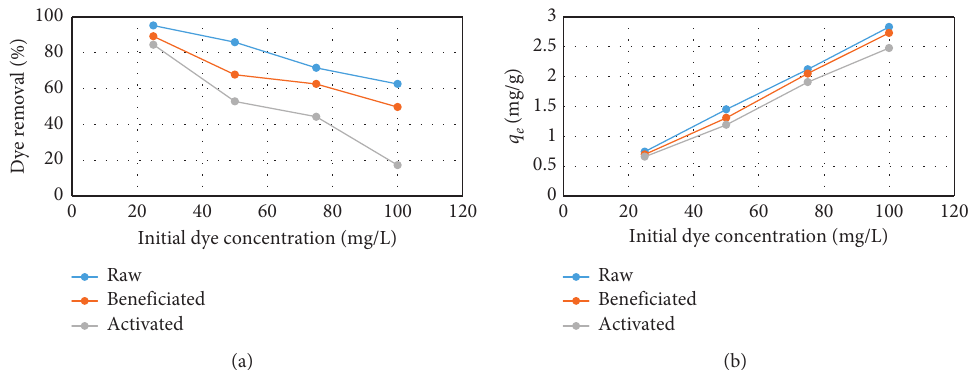
Figure 7: (a) Effect of initial dye concentration on MB dye removal by raw, beneficiated, and activated adsorbents. (b) Effect of initial dye concentration on MB dye adsorption capacity by raw, beneficiated, and activated adsorbents.